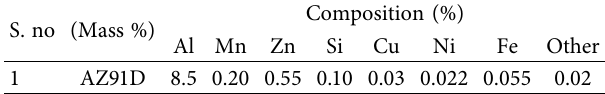
Table 1: Chemical composition of AZ91D-magnesium